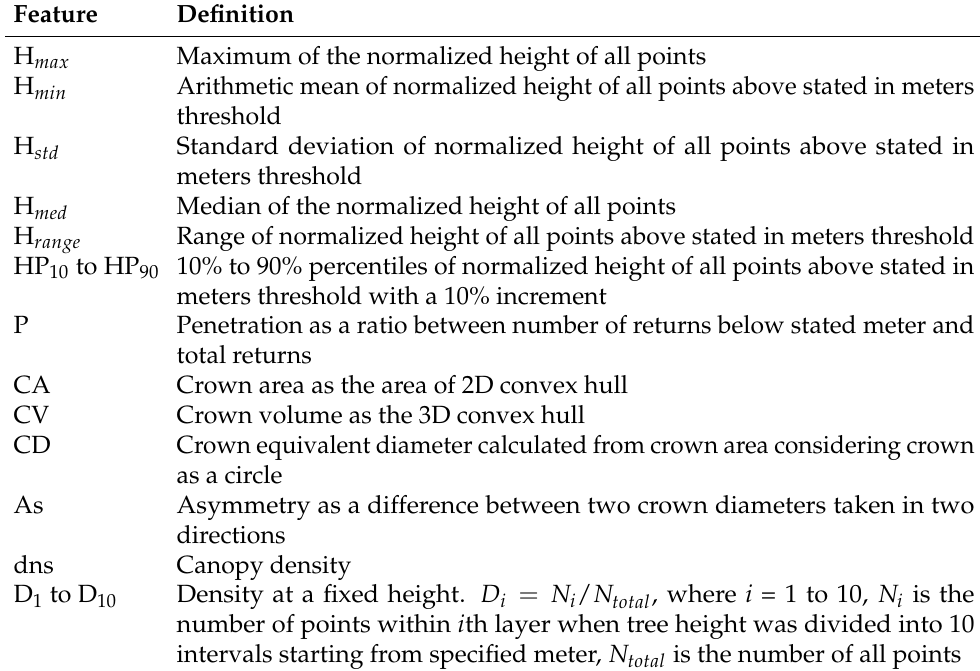
Table 1. Geometric features extracted from normalized LiDAR